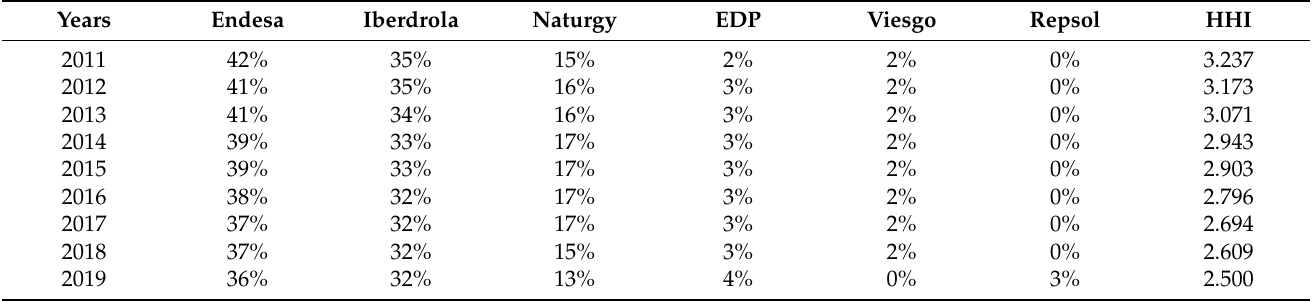
Table 4. Evolution of the Spanish market power of energy supplied for the domestic